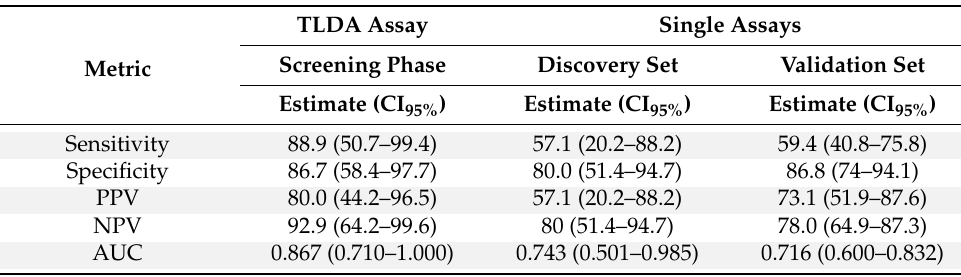
Table 2. Classification performance of the four-miR-based classifier used to distinguish colorectal cancer from non-cancer individuals.